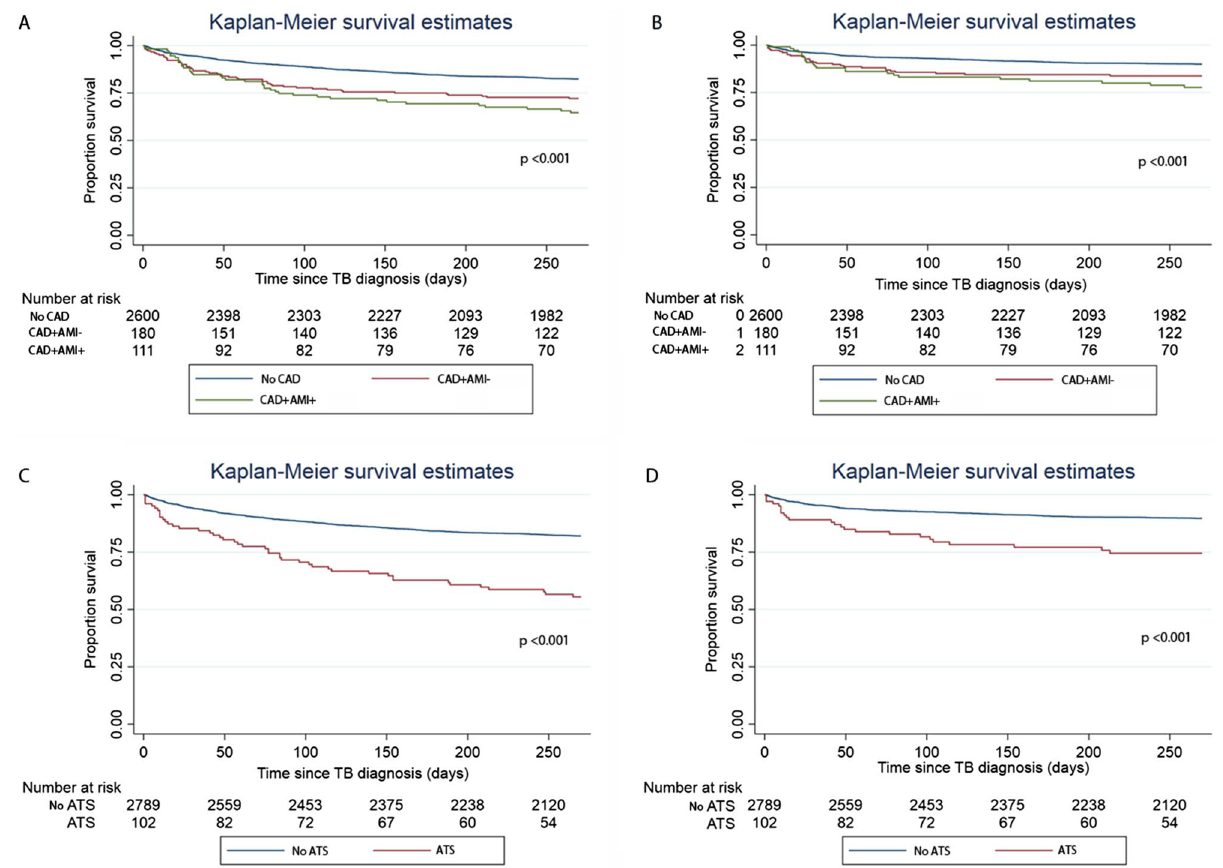
Figure 2. Kaplan Meier analysis on the association of pre-existing coronary artery disease (CAD) with ( A ) all-cause mortality and ( B ) infection-related mortality. Association of pre-existing atherothrombotic stroke (ATS) with ( C ) all-cause mortality and ( D ) infection-related mortality.CAD + AMI − , Pre-existing coronary artery disease without prior acute myocardial infarction; CAD + AMI + , Pre-existing coronary artery disease with prior acute myocardial